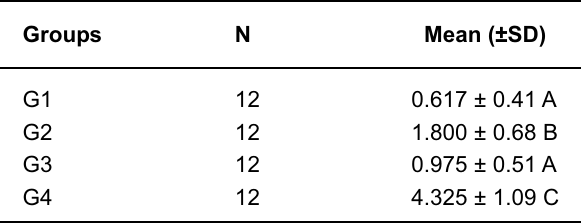
Same letter indicate no statistically significant differences among the